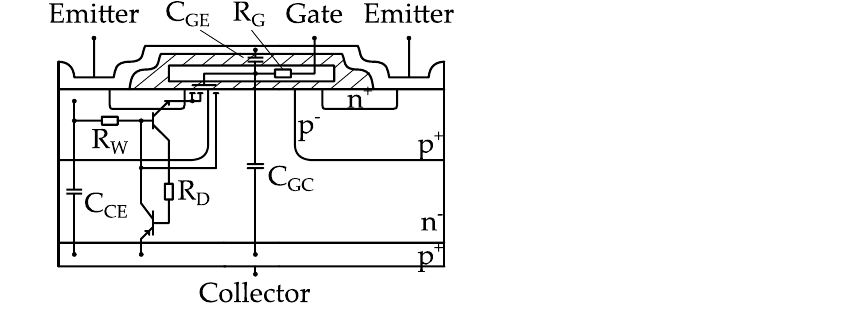
Figure 2. Cross-sectional drawing of an insulated gate bipolar transistor (IGBT) structure [37].